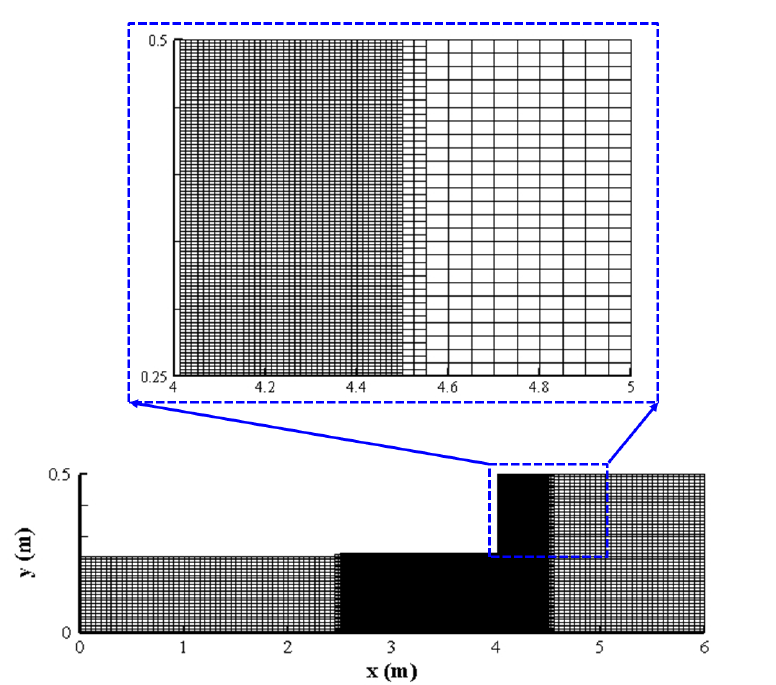
Figure 10. The computational grid for the dam break flow over an erodible channel with a sudden